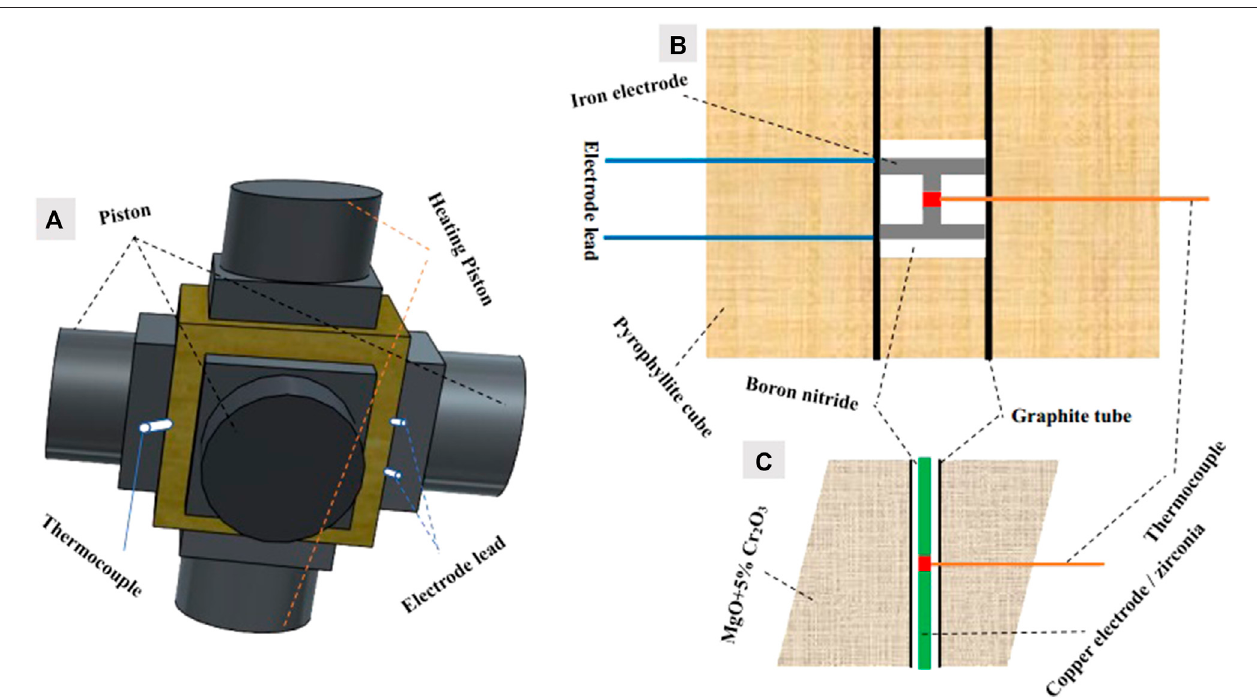
FIGURE 1 | Sample assembly drawing; (A) drawing of the large-volume pressing assembly, (B) drawing of the fi rst-stage anvil pressure calibration assembly, and (C) drawing of the second-stage anvil pressure calibration assembly.